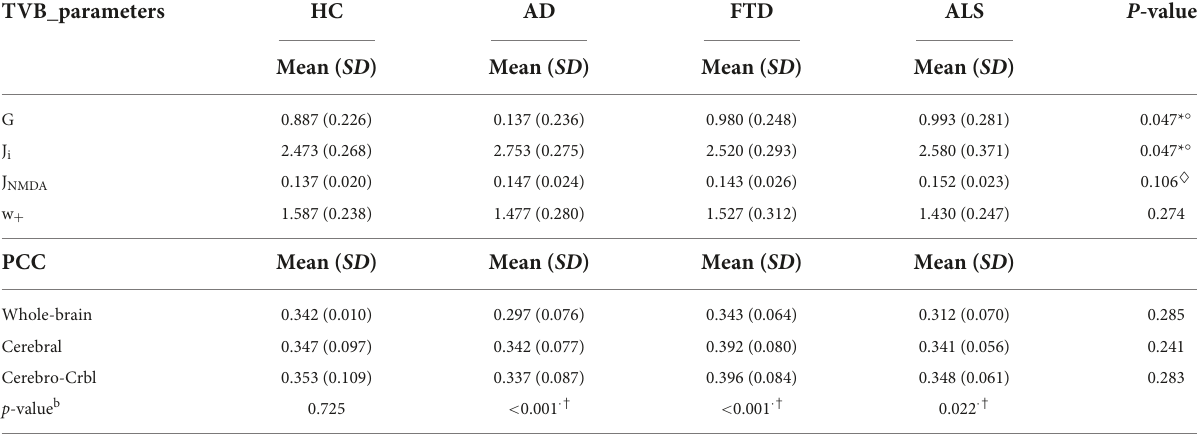
TABLE 2 Optimal model parameters and Pearson correlation coefficients per group.